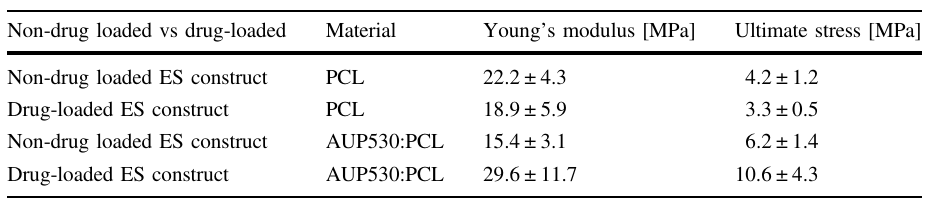
Fig. 5 Ex vivo tensile testing of the repair constructs using cadaveric sheep tendons ( A ) repair construct without reinforcement; B , C reinforced repair